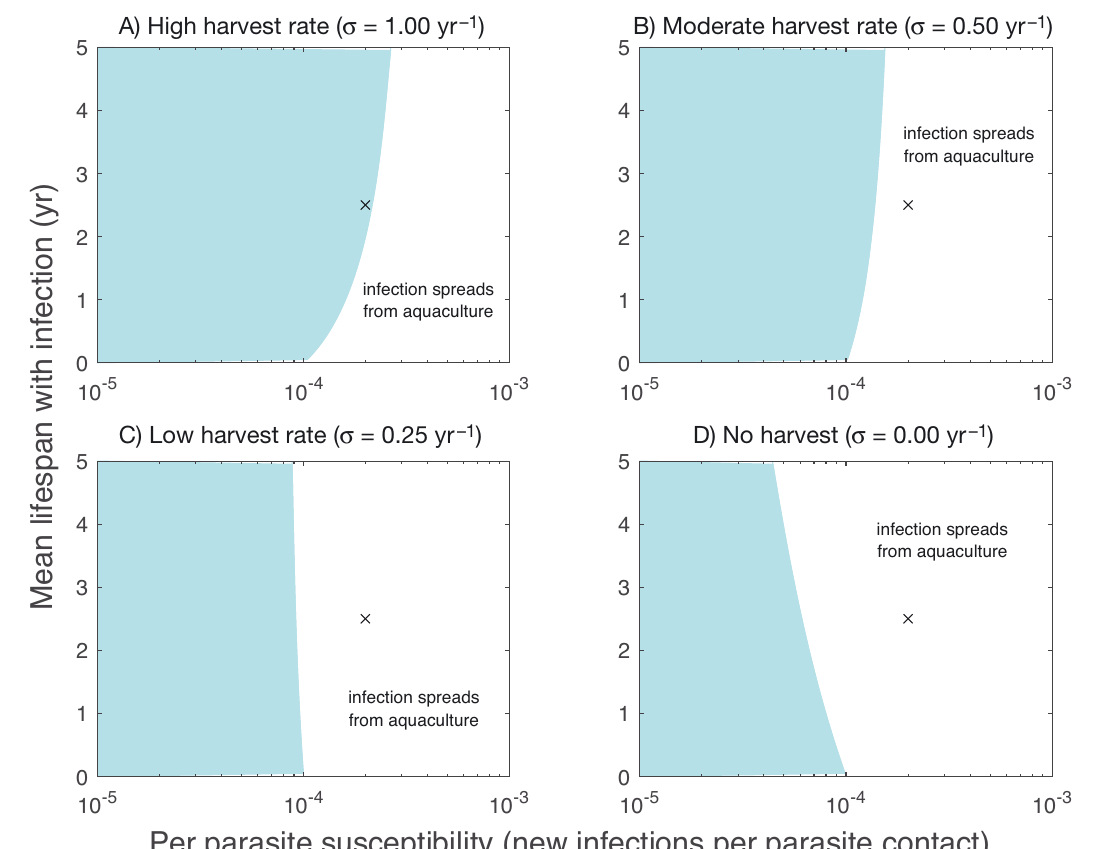
Fig. 2. Isoclines showing the threshold for disease emergence ( R 0,f > 1 to the right of each isocline, see Table 1 for parameter definitions) as a function of the susceptibility of planted oysters to Perkinsus marinus infection ( μ f ), the expected lifespan of planted oysters once infected with P. marinus (1/ δ + v f ), and the aquaculture harvest rate (A−D). The ‘×’ in each plot indicates the values of μ w and (1/ δ + v w ) of the wild oyster population. Both with and without harvest, increasing the susceptibility of planted oysters to P. marinus infection increases the spread of infection from aquaculture. In the absence of harvest, increasing the lifespan of planted oysters infected with P. marinus leads to a counterintuitive increase in the spread of infection